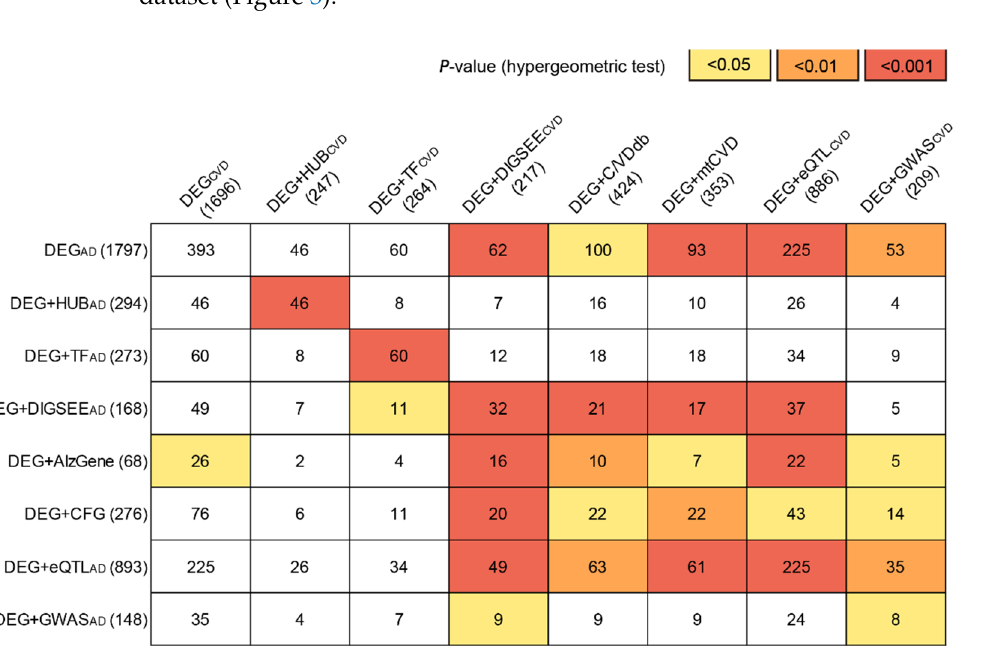
Figure 2. Measurement and comparison of the quality of the blood gene expression datasets using MetaQC. The quality indices were measured by iteratively selecting the four datasets from the six AD blood (A) and eleven CVD blood (B) gene expression datasets. The heights (y-axis) of each bar plot represents the mean values of each quality index. For example, the quality indices of GSE60993 were measured 120 times ( 10 C 3 ). The mean values of the 120 measures for each quality index were calculated. Stars denote the first ranking dataset, which means the dataset had the best quality for a specific quality index. AD, Alzheimer’s disease; CVD, cardiovascular disease; IQC, internal quality control; EQC, external quality control; CQCg, consistency quality control (gene); CQCp, consistency quality control (pathway); AQCg, accuracy quality control (gene); AQCp, accuracy quality control (pathway); SMR, standardized mean rank.